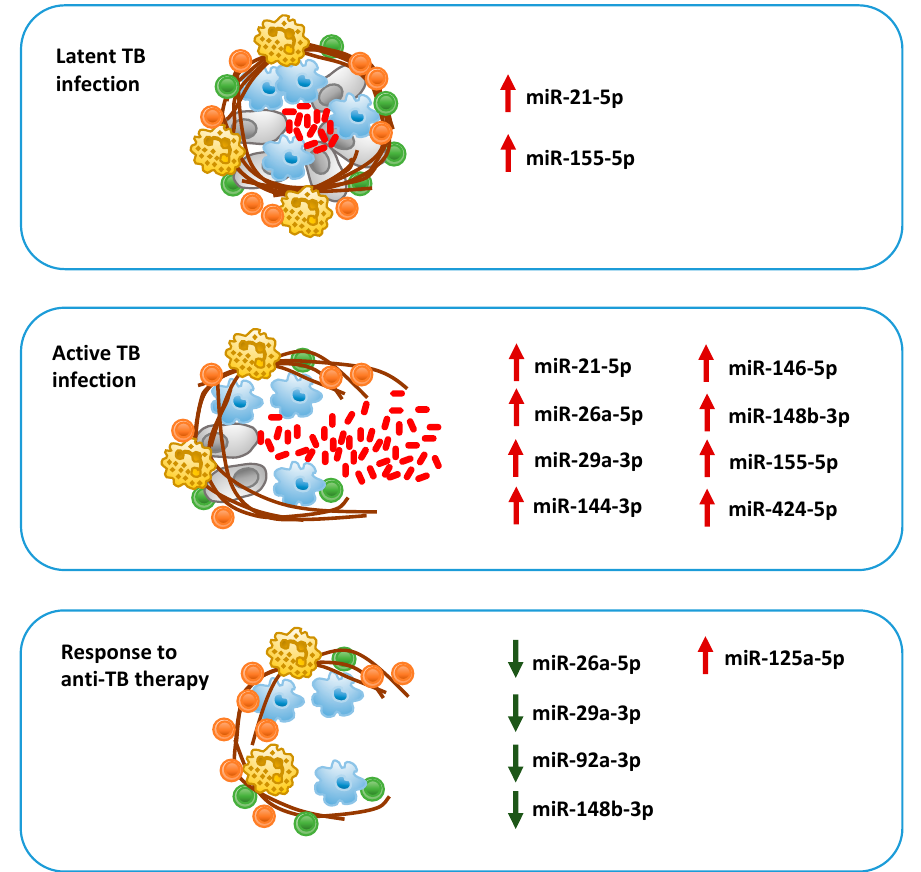
Figure 3. Graphical representation of circulating miRNAs, which are significantly up-regulated (red arrow) or down-regulated (green arrow) in subjects with latent tuberculosis (TB) infection, active TB, or who responded to anti-TB therapy, and have been proposed as candidate biomarkers.